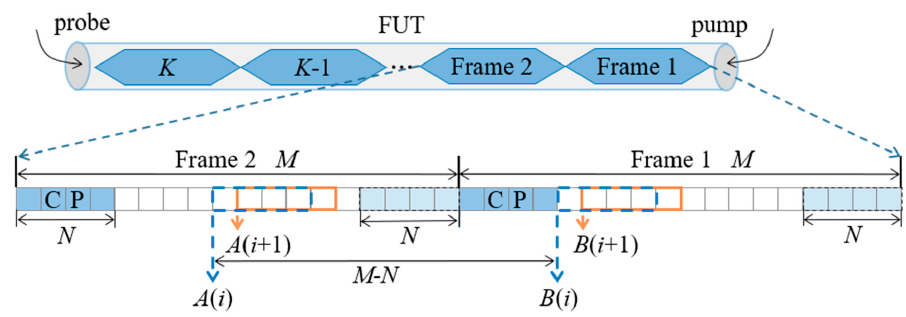
Figure 2. Schematic diagram of frame synchronization method. FUT: fiber under test; CP: cyclic prefix.